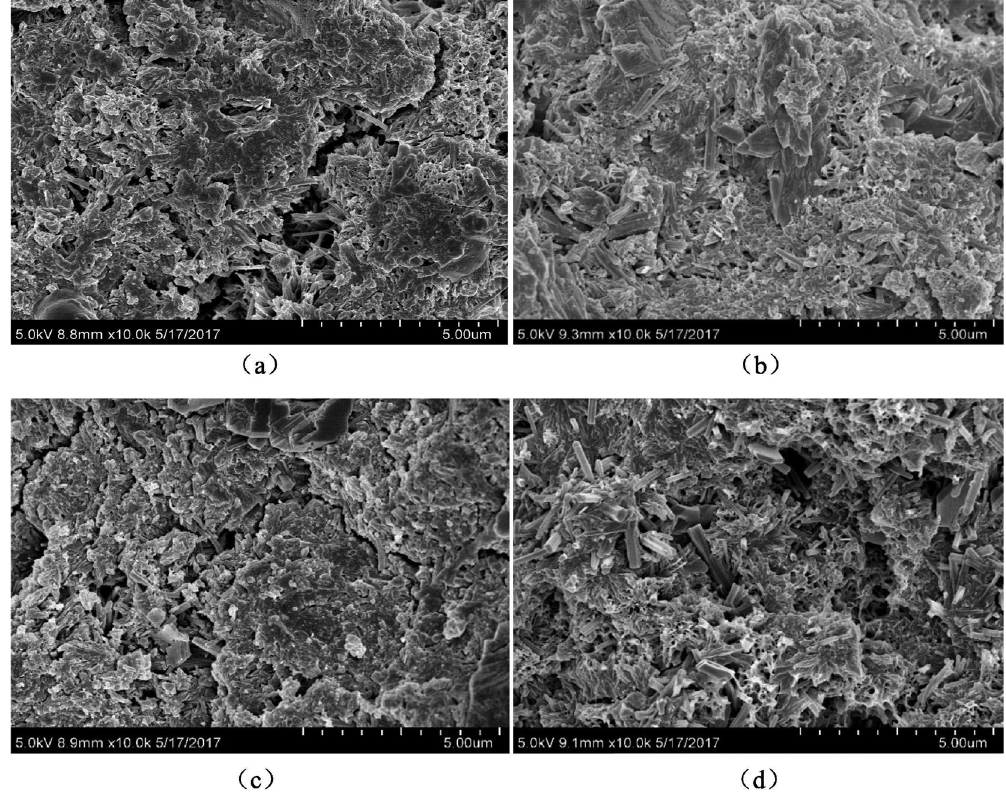
Figure 22: Fractured surface morphology of four kinds of hardened cement pastes [ 133 ] : ( a ) blank constant, ( b ) graphene oxide cement, ( c ) nano - silica cement, and ( d ) hybrid nano - materials